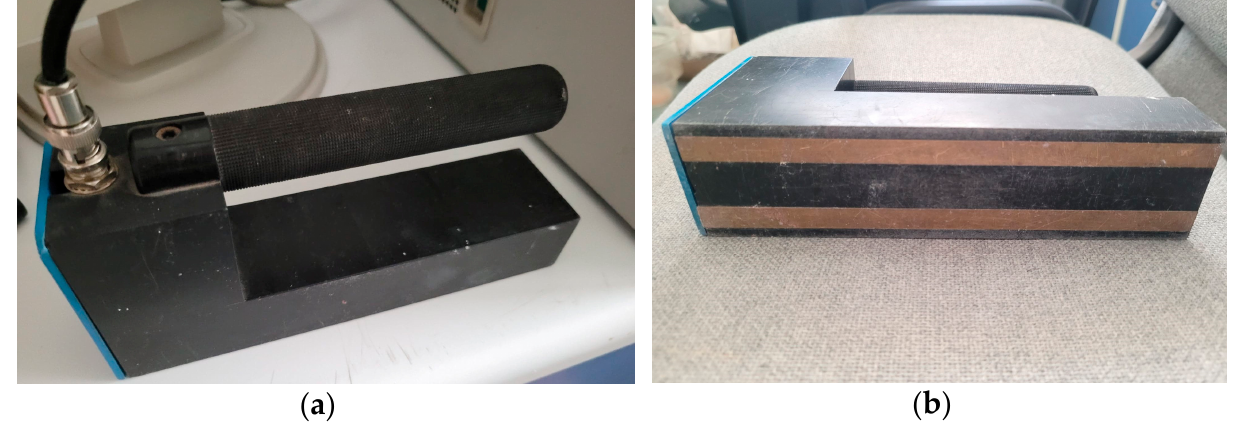
Figure 2. S1 non-invasive TDR sensor [42] . ( a ) Isometric view, ( b ) view from the bottom.